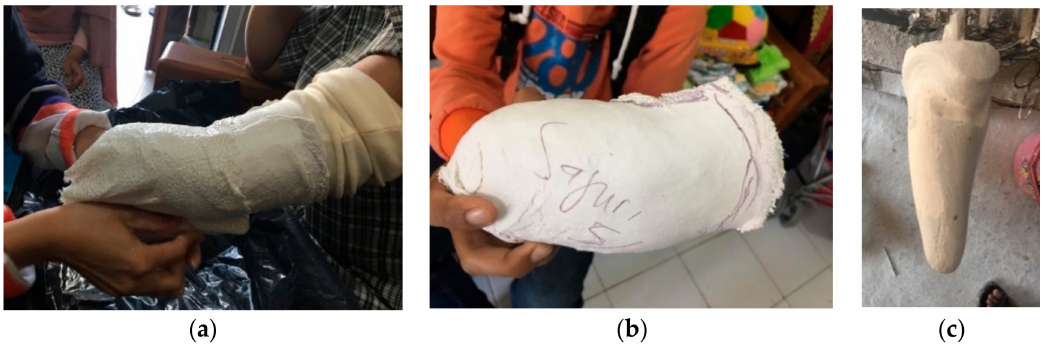
Figure 5. ( a ) The process of negative mold fabrication; ( b ) the negative mold; ( c ) the positive gip after